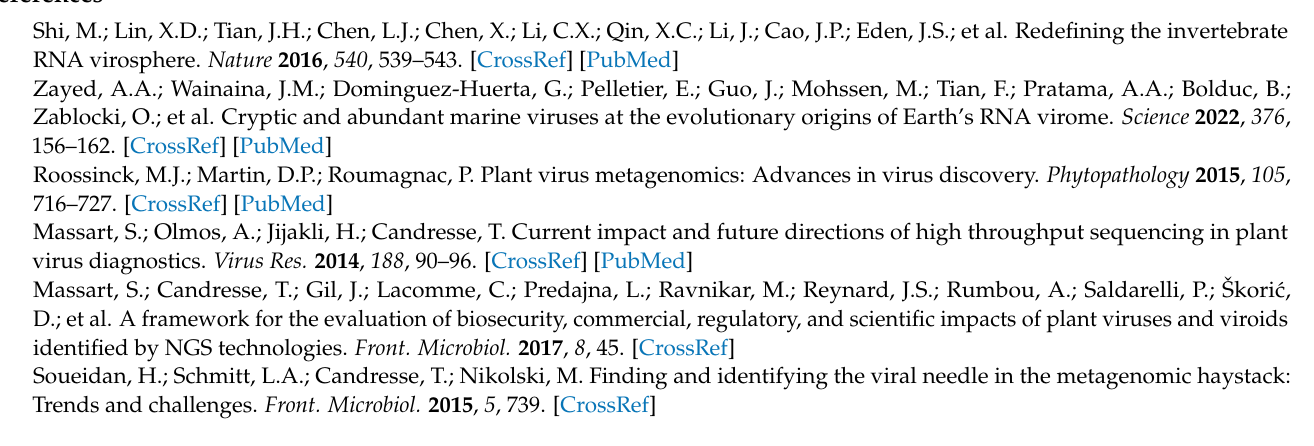
Figure S4: Multiple protein sequence alignments of the end of the C-terminal conserved domain of the P9 proteins of GaJV-1, CaJV-1 and CaJV-2 and of proteins encoded by contigs identified by TBLASTN analysis in the transcriptome assembly of various plant species; Table S1: Primers used for the detection or the molecular characterization of the isolates of GaJV1 in the present